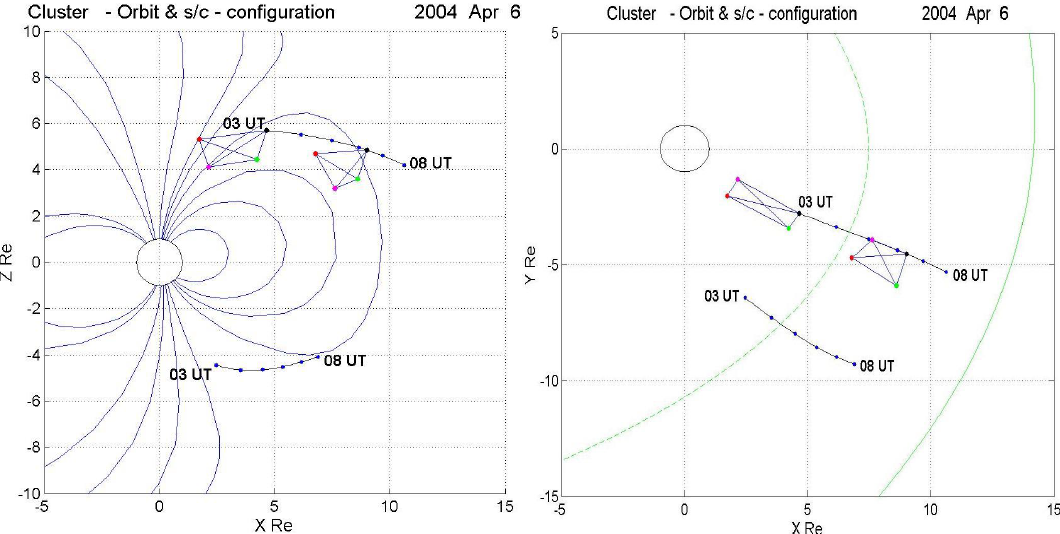
Fig. 1. Cluster s/c1 and Double Star TC-1 tracks in GSM coordinates for the interval 03:00 to 08:00 UT on 6 April 2004. The Cluster orbit also shows two spacecraft configurations (scaled up by a factor x50). Each orbit has hour markers. Model field lines are shown for the projection into the X,Z plane and cuts through the bow shock and magnetopause are shown for the X,Y plane. For the X,Z plane field lines are drawn from the Tsyganenko ’89 model for